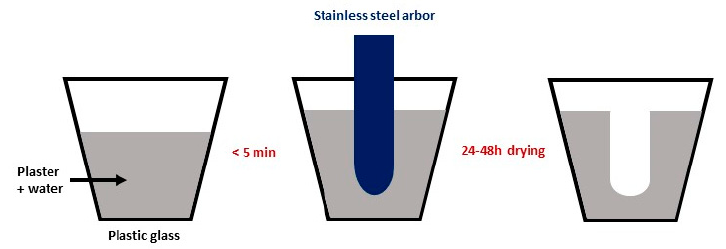
Figure 1. Fabrication of the molds for slip